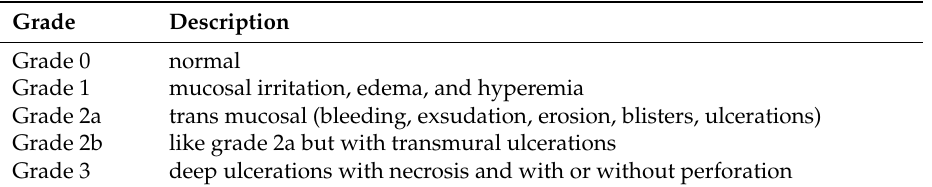
Table 4. Grading of injury after acid and base